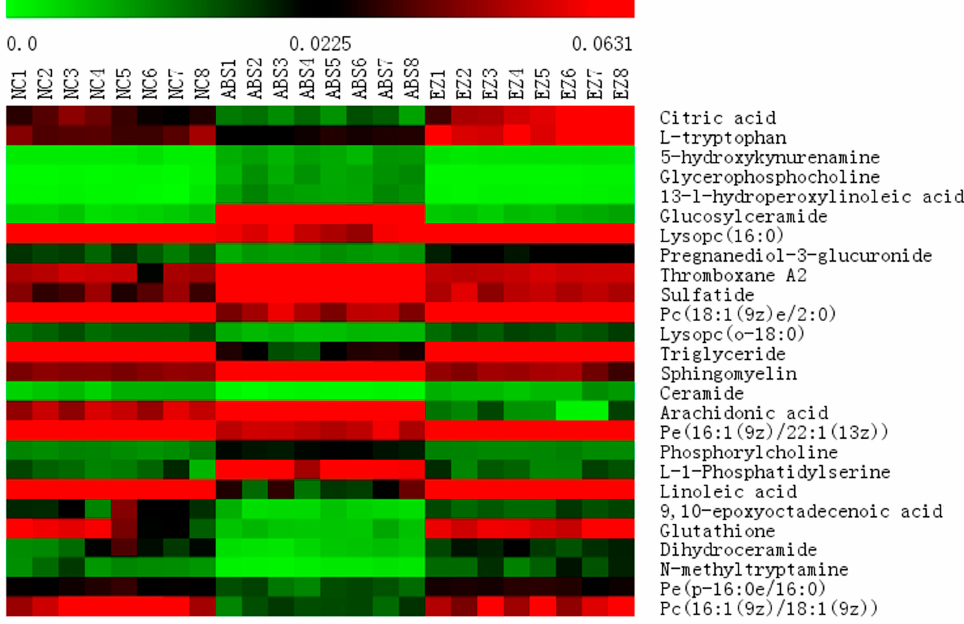
Figure 6. Heat map of differential metabolites.